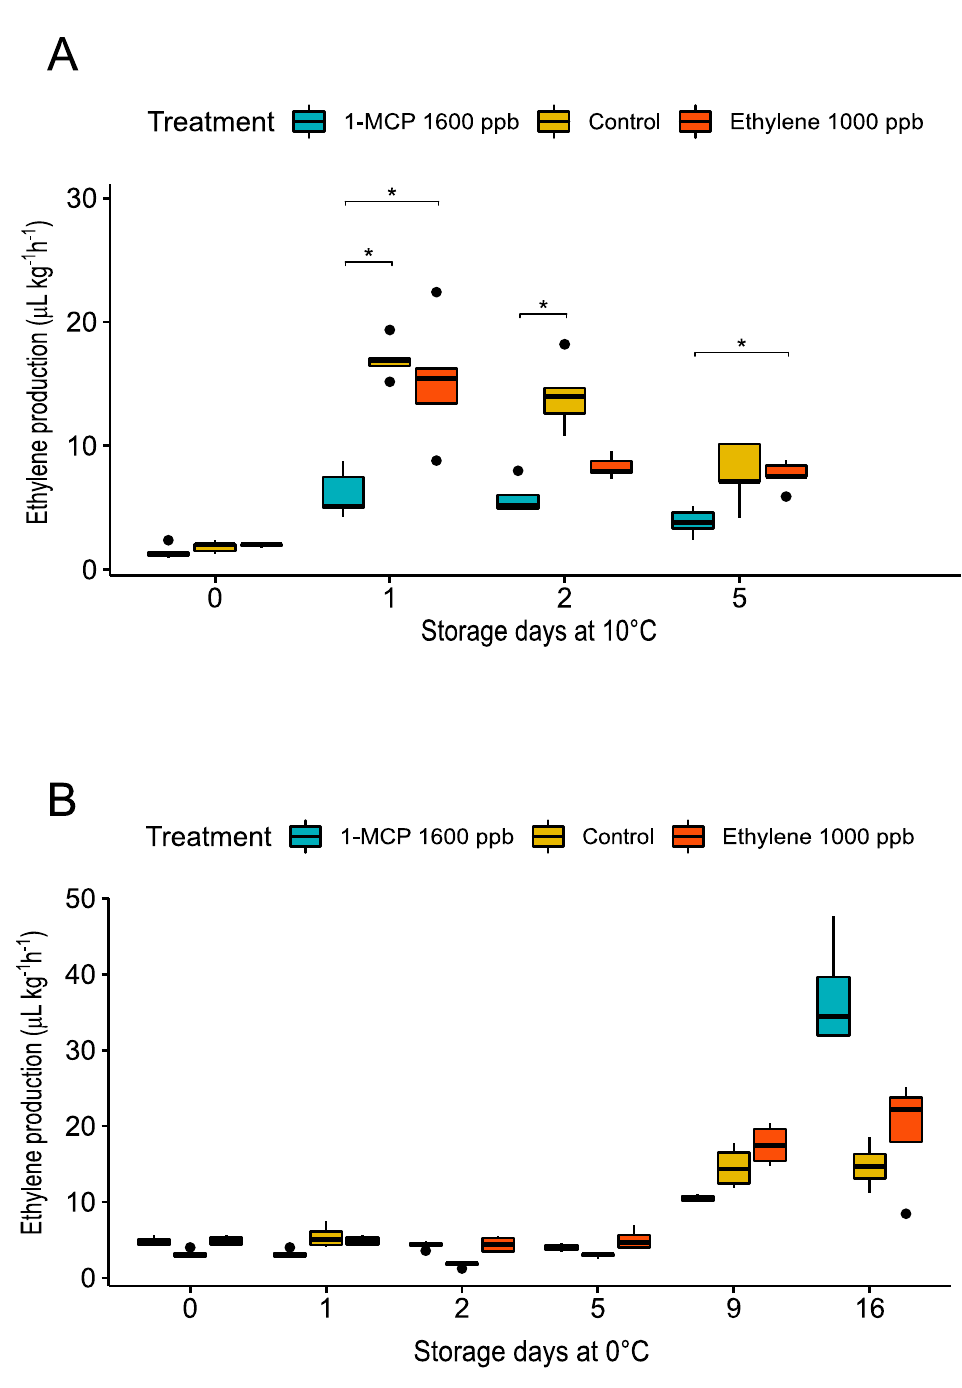
Figure 6. Ethylene production of raspberry ( Rubus idaeus ‘Heritage’) fruit during treatment with ethylene and 1-methyl cyclopropane (1-MCP). The storage assay was performed at the W stage of raspberry and stored for 5 and 16 days at 10 ◦ C ( A ) and 0 ◦ C ( B ), respectively. Ethylene production ( µ L kg − 1 h − 1 ) was determined for ethylene and 1-MCP-treated fruits and controls. Data represent the means ± S.D. from five sample units (each containing ten fruits). Asterisks indicate significant differences between treatments at the same storage time ( p ≤ 0.05). Boxplots show each group’s distribution (treatment) and the black line (central value in the box) signs the median value. Points out of the boxplots show outlier values.